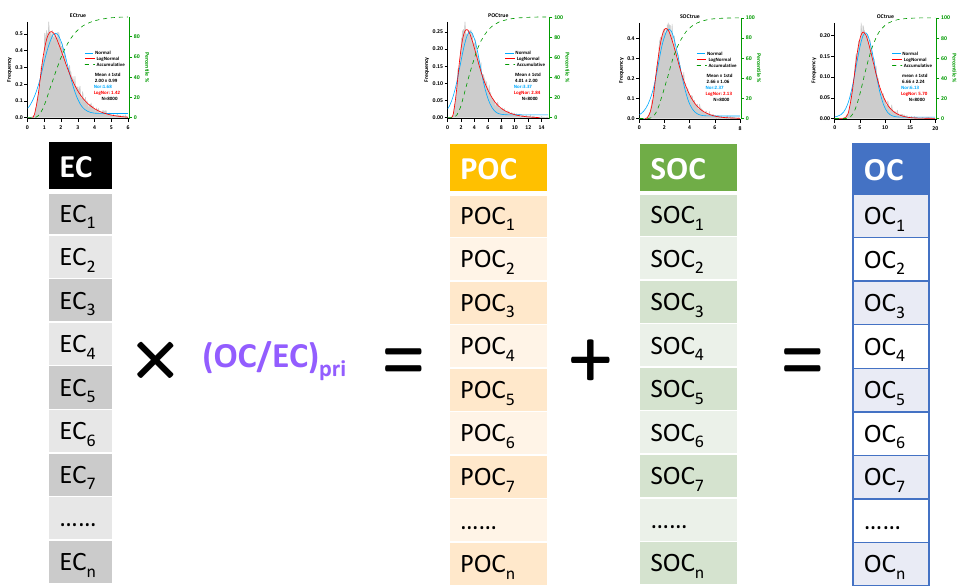
Figure 2. Schematic diagram of pseudorandom number generation for the single emission source scenario that assumes (OC / EC) pri is a single value. The data series (EC and SOC), generated by Mersenne twister (MT) pseudorandom number generator, statistically follow a log-normal distribution, but the sequence of each data point is randomly